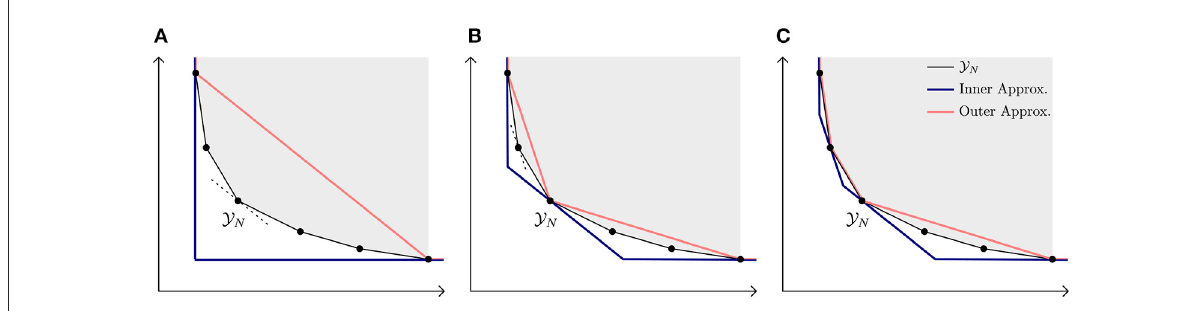
FIGURE3 Obtaining inner and outer approximations (approximately). (A) Initial approximations based on the starting points. (B) After one iteration, the approximations are improved. (C) Approximations are further improved in second iteration.